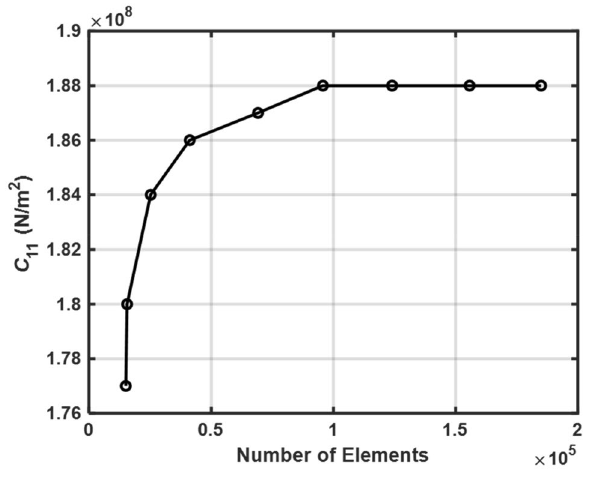
Figure 5. Mesh convergence study to calculate effective property C 11 for non-auxetic piezocomposite at 24% volume